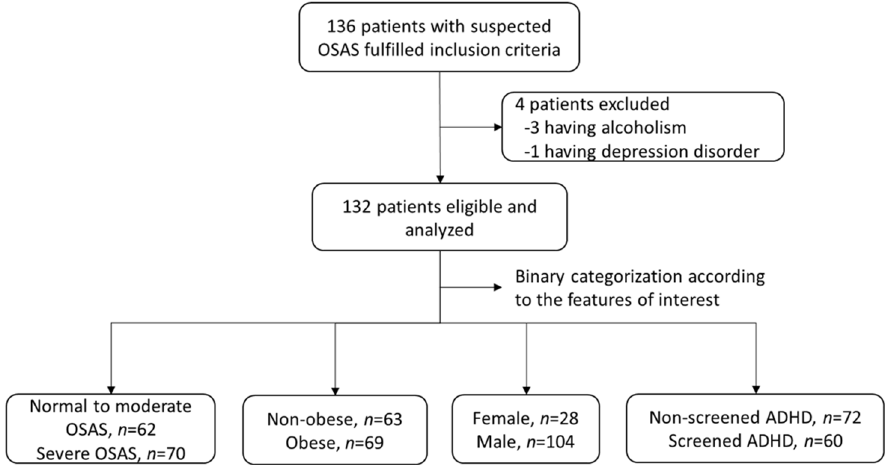
Figure 1. The patient enrollment flowchart.